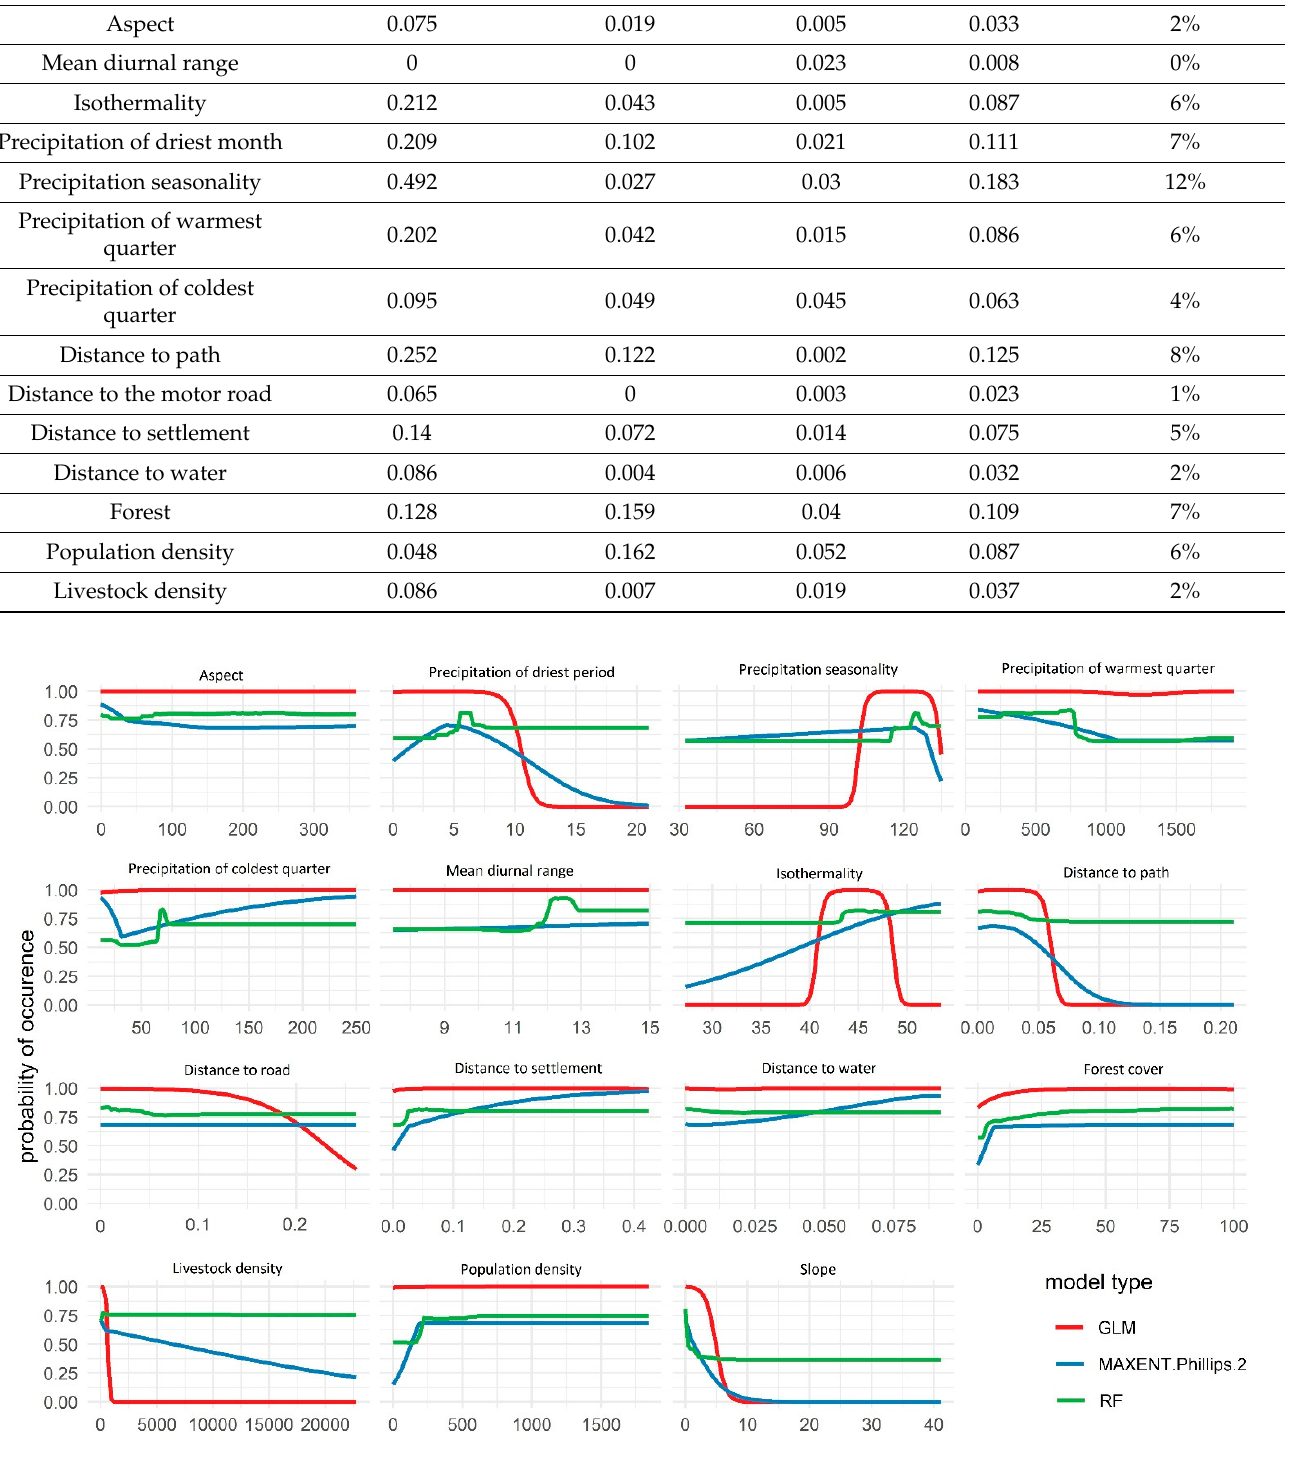
Figure 4. Performance predictions of various modeling approaches used to develop a current suit- able habitat model based on true skill statistics. 0.89